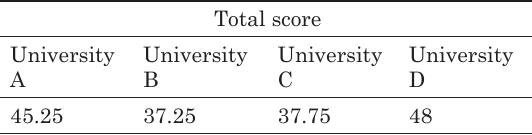
Table 2. Total mapping score comparison